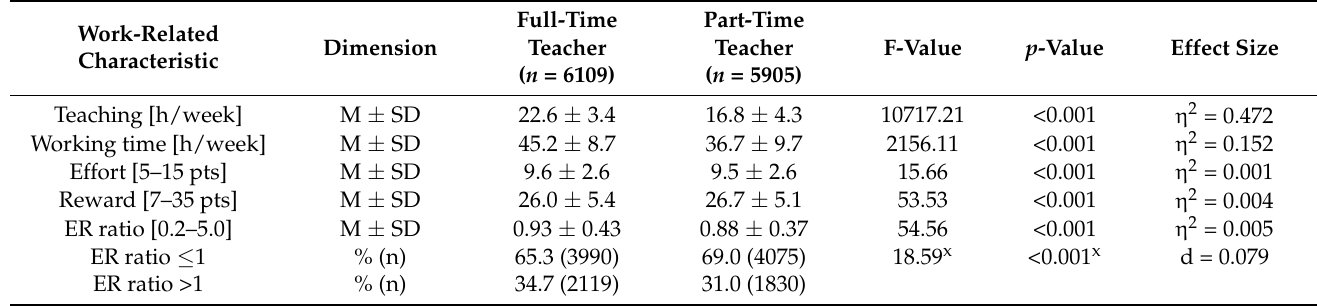
Table 4. Main effects of the work-related characteristics of full-time and part-time teachers.